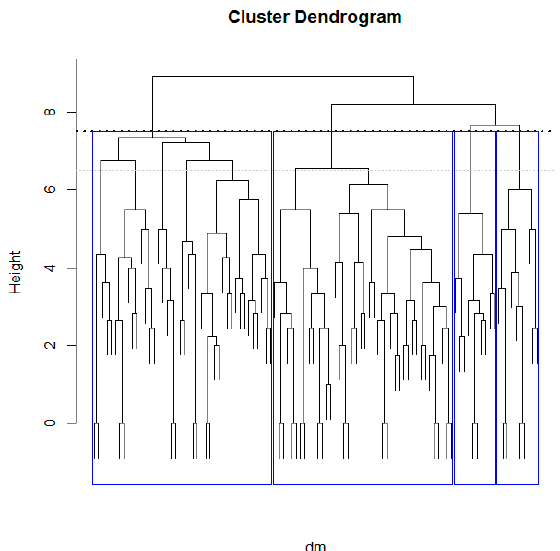
Figure 6. Hierarchical clustering with the dendrogram. Table 6. Predominant investors’ profiles.